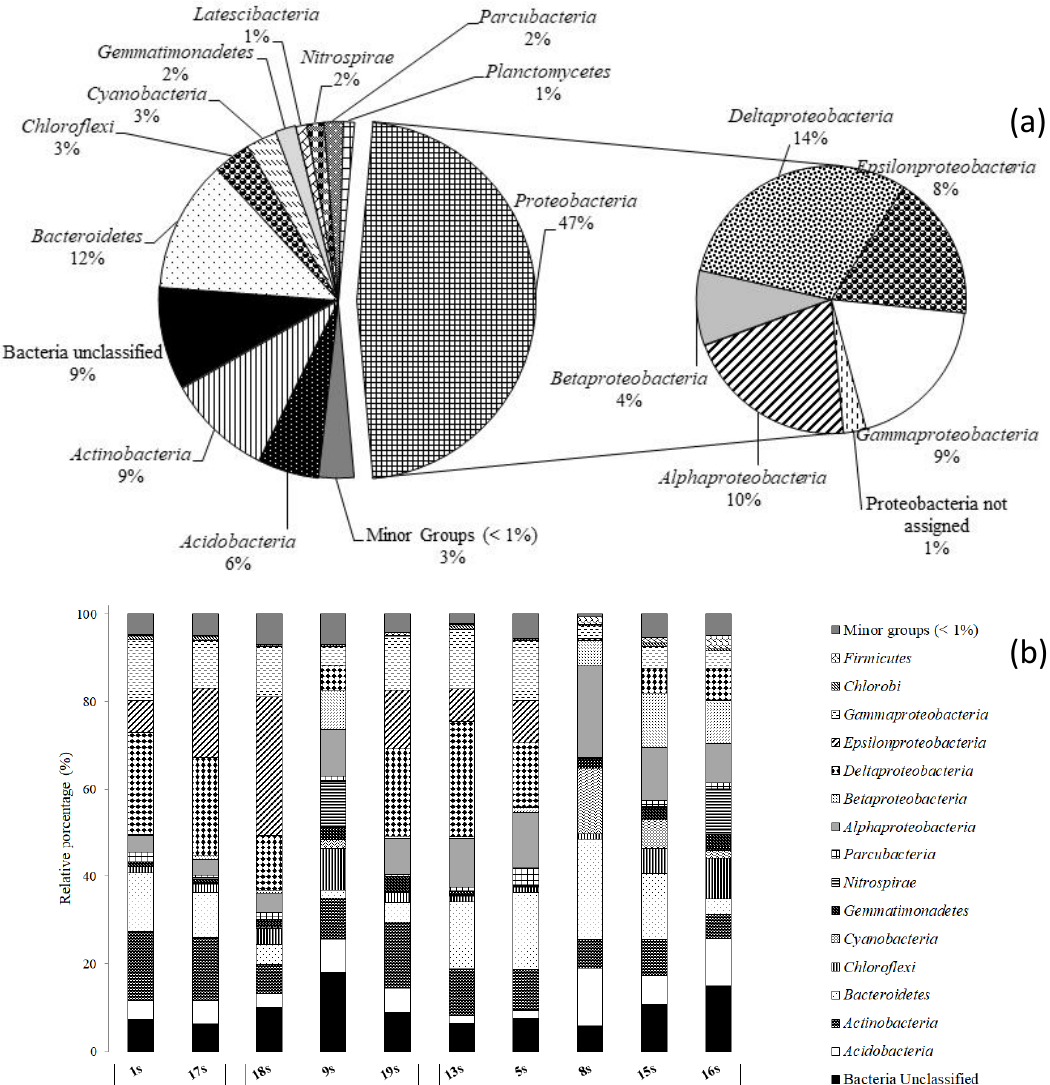
Figure 4. Phylogenetic groups retrieved in ( a ) all sediment samples and ( b ) at each sampling site along the Pasvik River.